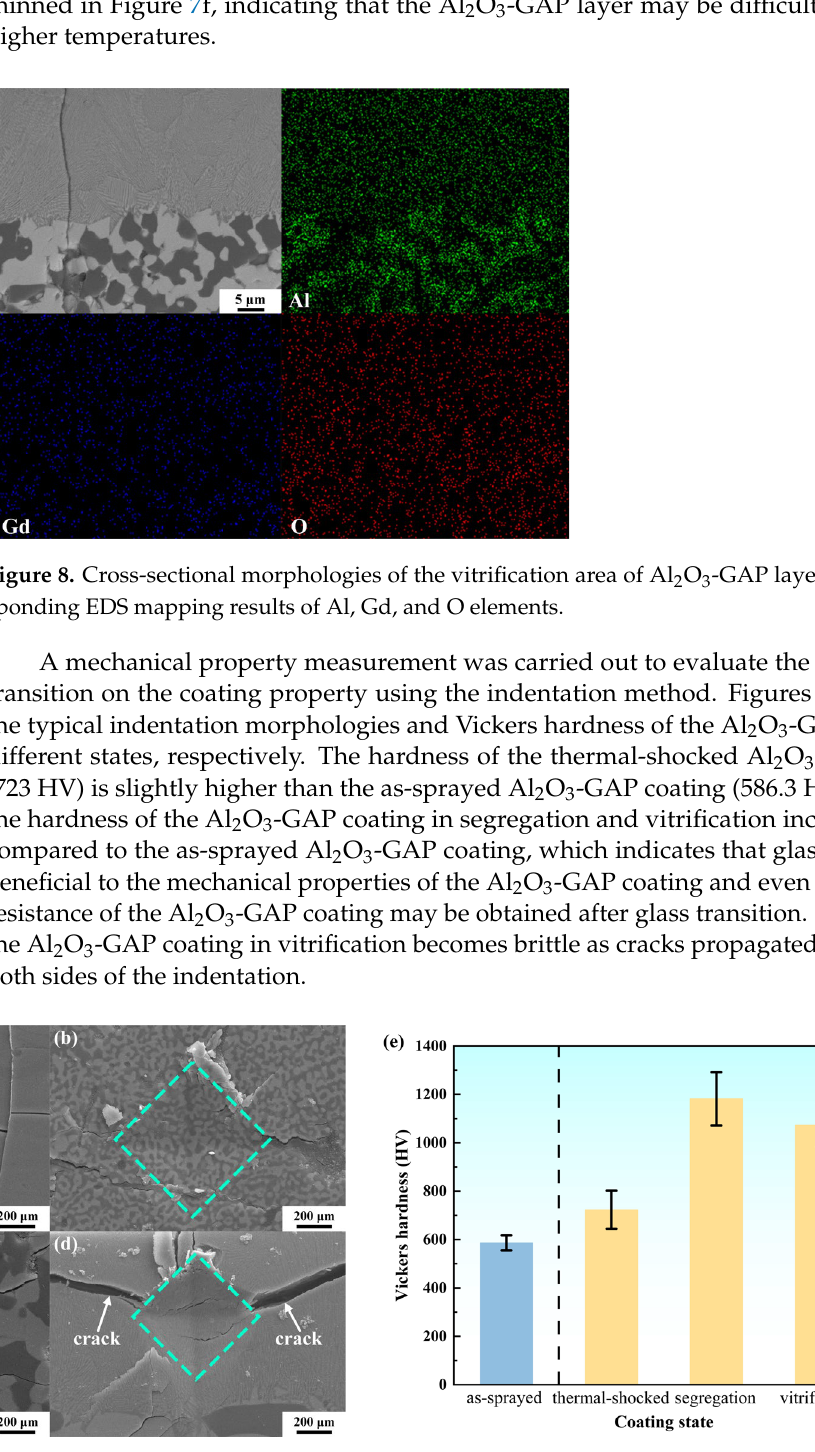
Figure 7. ( a ) Macroscopic and ( b – f ) cross-sectional morphologies of AGAP-YSZ coating after ther- mal shock test.